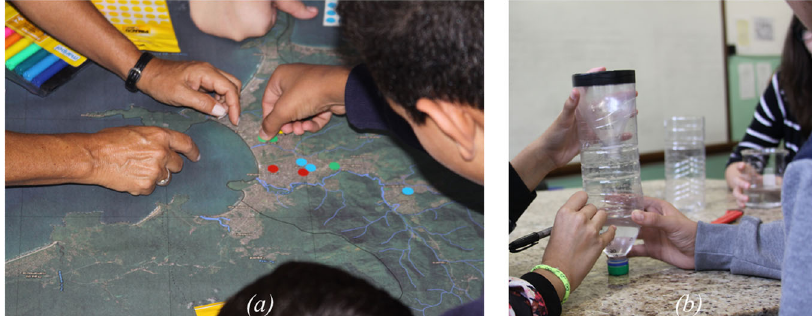
Fig. 5 Activities in Presidente Tancredo de Almeida Neves Municipal School, in Ubatuba – Southeast of Brazil. a Social cartography to identify risks around the school in Ubatuba downtown; ( b ) Artisanal pluviometer to build a network of rain monitoring. Source: